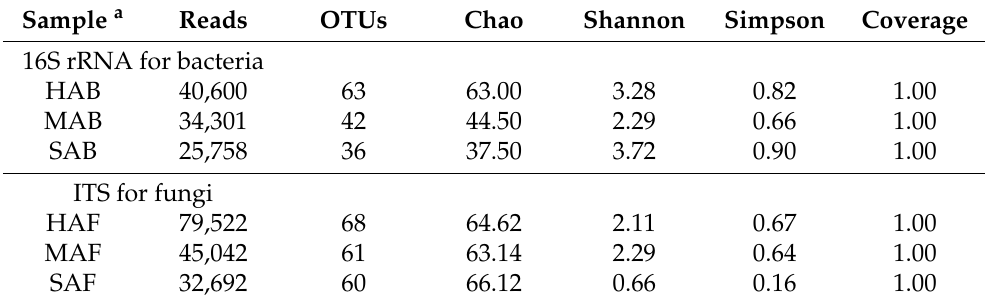
Table 1. α -diversity estimation of the 16S rRNA gene and ITS libraries from the Illumina Miseq